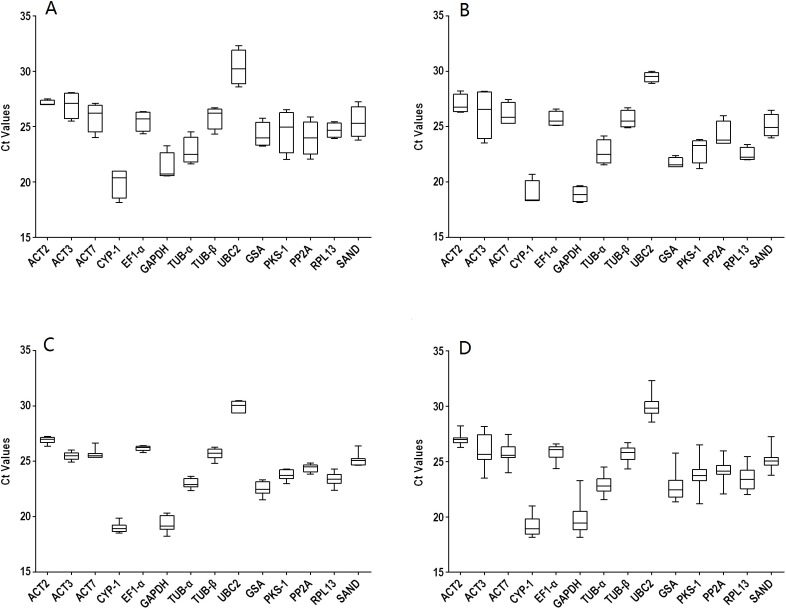
Distribution overview of the expression profiles of 14 candidate genes.(A) different tissues, (B) developmental stage seedlings, (C) stress-treated seedlings, (D) data from all experimental conditions combined. The line across the box is the median. The box indicates the 25th and 75th percentiles; whisker caps indicate the maximum and minimum values; and dots indicate outliers.